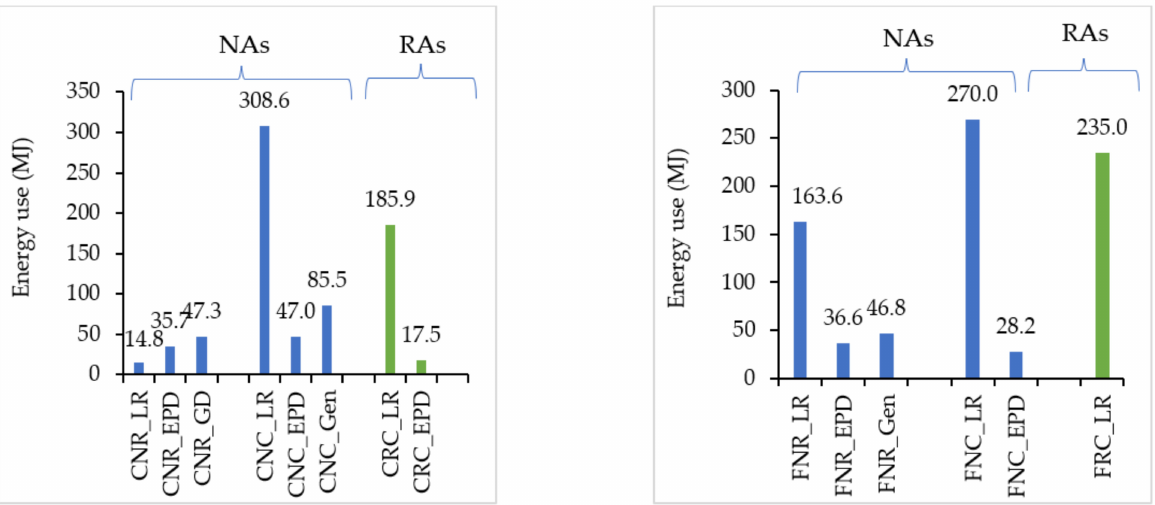
Figure 8. Comparison of the results in terms of energy use (MJ) of NAs and RAs coarse ( left ) and fine ( right ) aggregates from the different